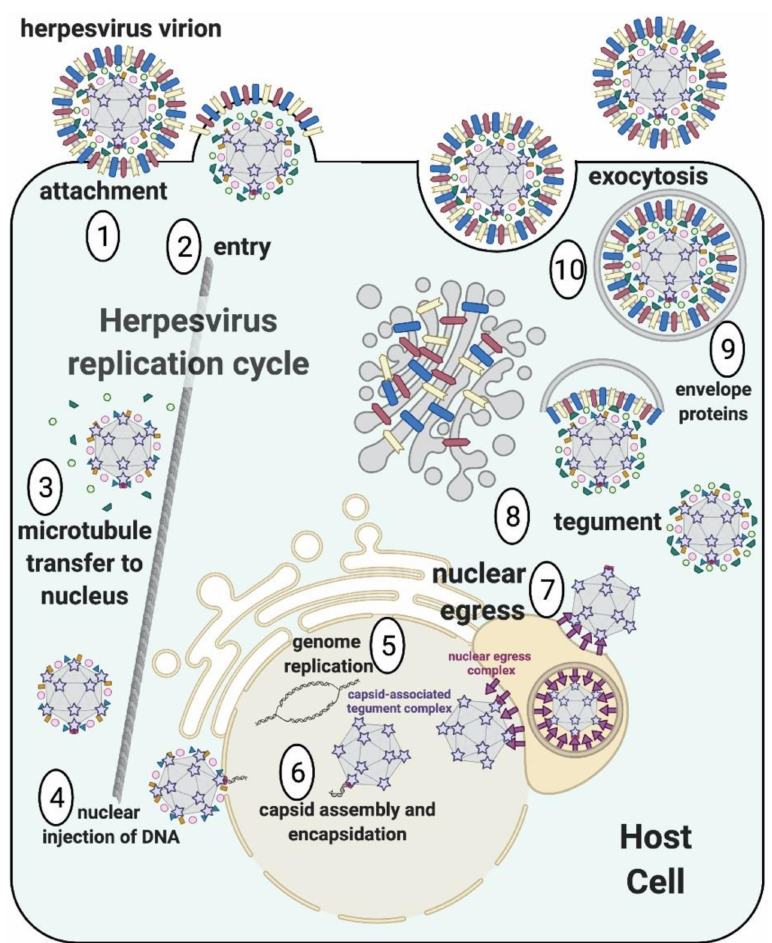
Figure 1. Overview of the herpesvirus replication cycle. An incoming virion attaches to the host cellular membrane (1) and fuses with it, releasing the capsid into the cytoplasm (2). Some of the outer protein layer, termed the tegument, dissociates upon entry, and the capsid traffics to the nucleus via microtubules (3). The capsid then docks at the nuclear pore and releases the DNA genome into the nucleus (4), where the incoming genome undergoes replication (5). Progeny genomes are packaged into capsids decorated with auxiliary proteins (e.g., the capsid-associated tegument complex) (6) and bud through the nuclear envelope with the help of the nuclear egress complex into the cytoplasm (7). Capsids gain a tegument layer (8) and acquire a protein-studded lipid envelope by budding at vesicles derived from trans -Golgi network and endosomes (9). The mature virions use the exocytic pathway to exit the cell (10). The figure was created with BioRender.com, accessed on 19 September